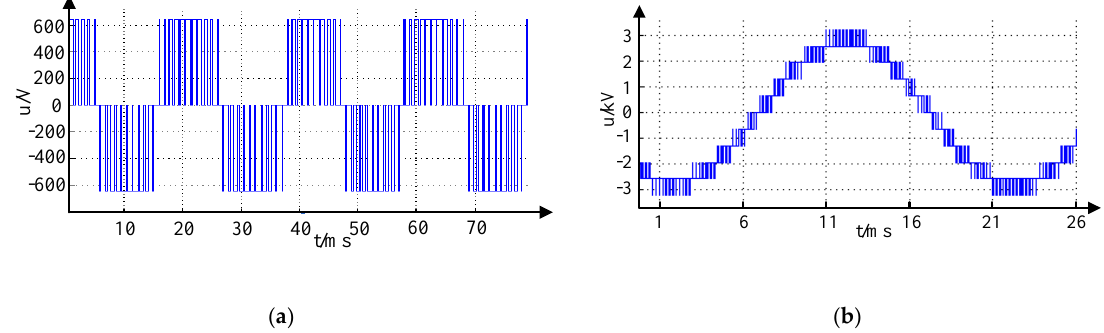
Figure 11. The output voltage waveform: ( a ) single power module; ( b ) five power modules.